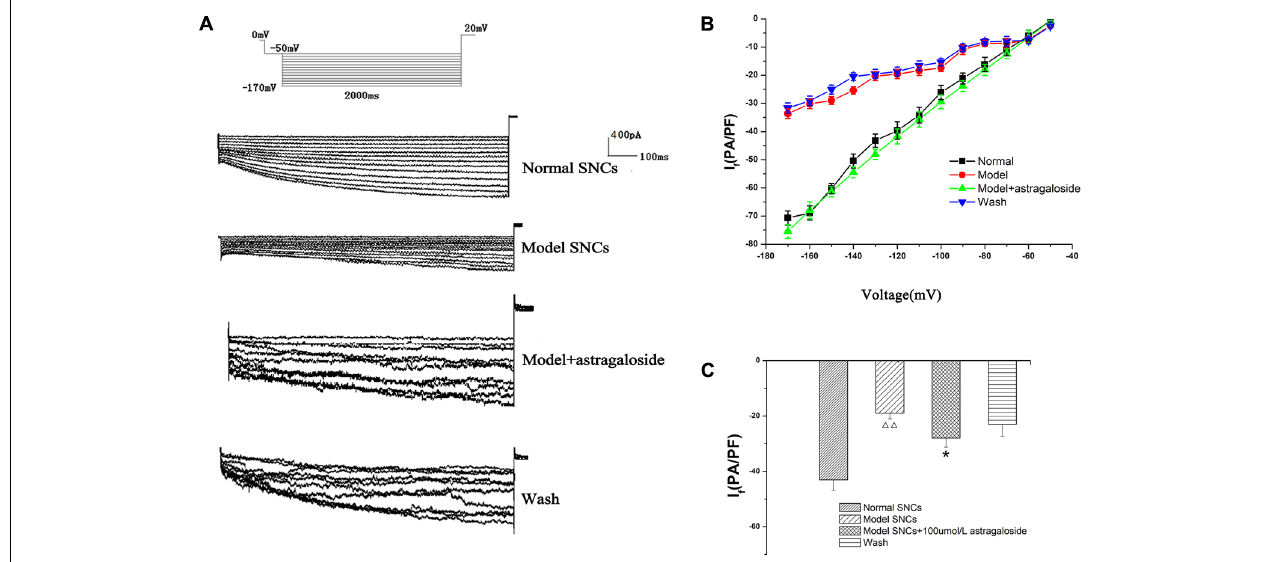
FIGURE 4 | (A) Differences in the SSA curves of the I f in each group ( n = 10). (B) Effect of astragaloside on the V 1 / 2 of the I f in damaged neonatal rabbit SAN cells. ∗ P < 0.05 vs. the normal group; (cid:49) P < 0.05 vs. the I/R model group. (C) Effect of astragaloside on the slope factor k of the half activation voltage of the I damaged SAN cells. ∗ P < 0.05 vs. the normal group; (cid:49) P < 0.05 vs. the I/R model